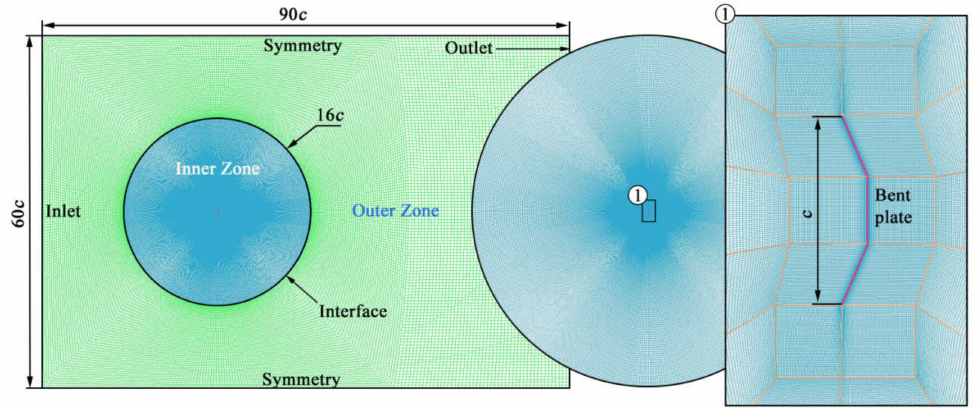
Figure 3. Mesh details and boundary conditions. The Inner Zone contains 10.5 × 10 4 elements with first layer element height of 2 × 10 − 3 chord length, and the Outer Zone contains 4.3 × 10 4